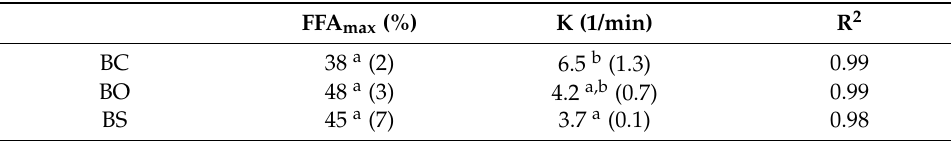
Figure 2. Free fatty acids (FFA) released during in vitro digestion of baked buns ( a ) and steamed buns ( b ). Control buns (squares), buns made with olive oleogel (circles), and buns made with sunflower oleogel (triangles). Table 3. Kinetic parameters of lipid digestion in baked buns.